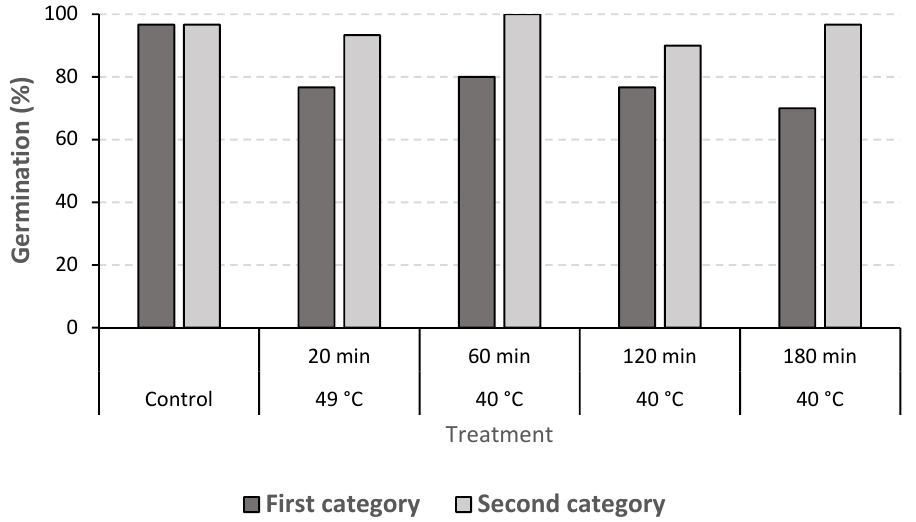
Figure 4. Seed Germination (%) of first or second clove category (first category cloves length >15 mm; second category 10–15 mm clove length), tested in response to dry heat, during the second experiment with high temperatures.